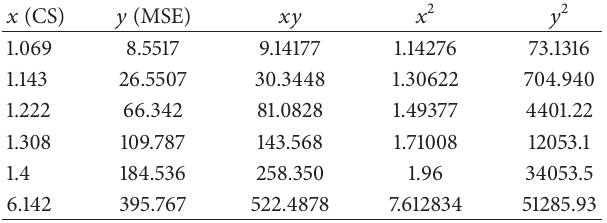
Table 2: Average metrics values for breast cancer images.